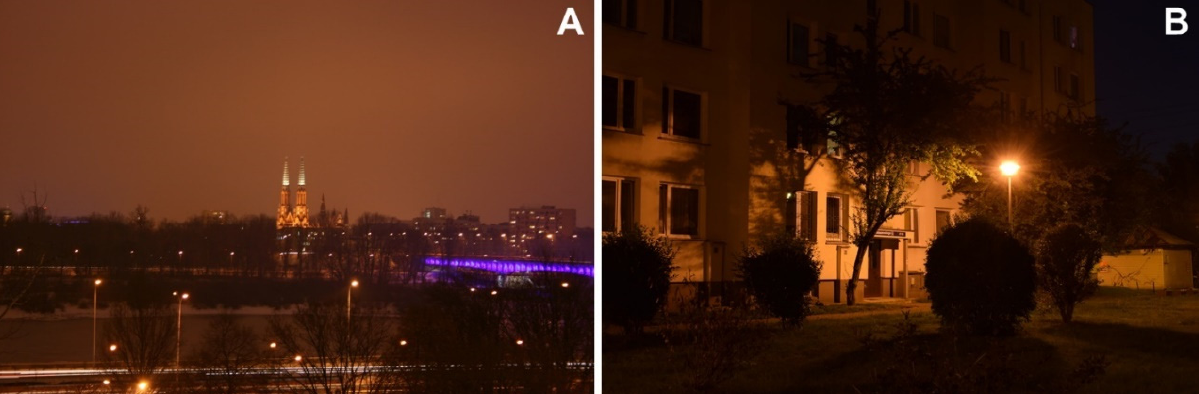
Figure 1. Examples of light pollution consequences: ( A )—the lack of stars’ visibility over the city of Warsaw due to skyglow, ( B )—obtrusive light (light intrusion) into the residential building (both photos: K. Skar ż y ń ski).